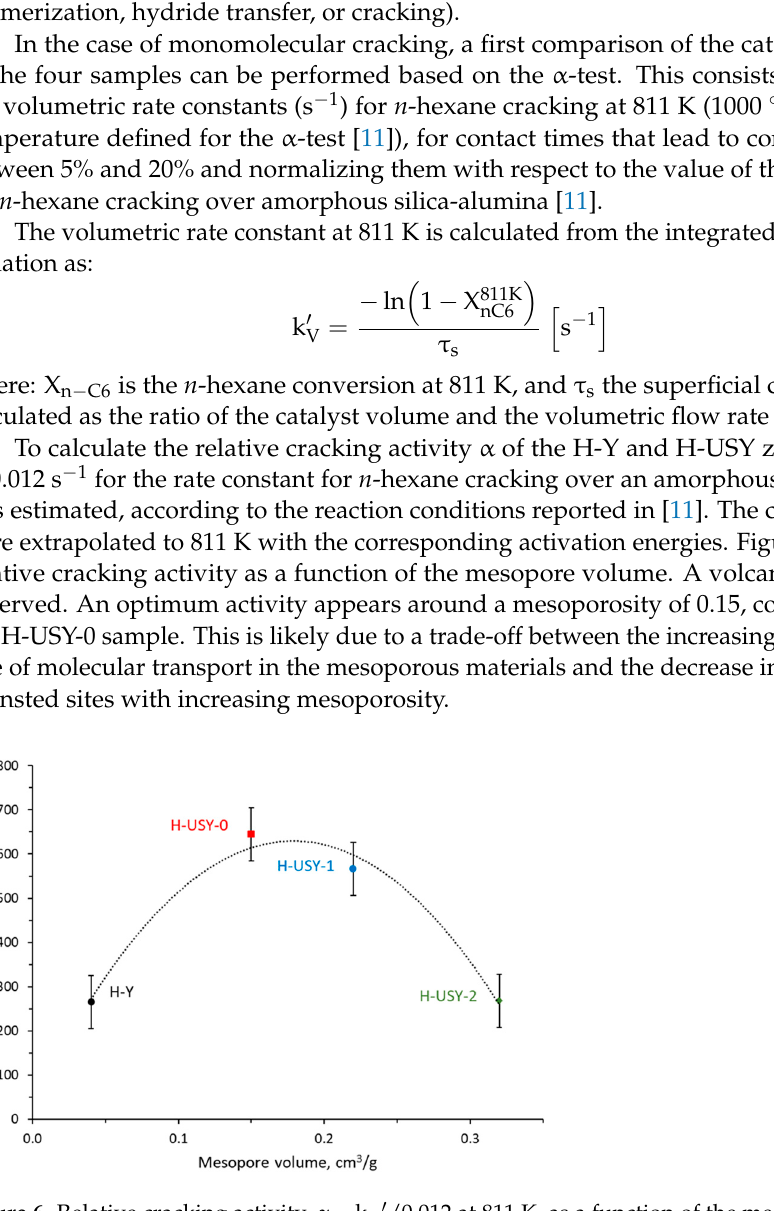
(cid:48) /0.012 at 811 K, as a function of the mesopore Figure 6. Relative cracking activity, α = k V ’/0.012 at 811 K, as a function of the mesopore volume. Figure 6. Relative cracking activity, α = k V